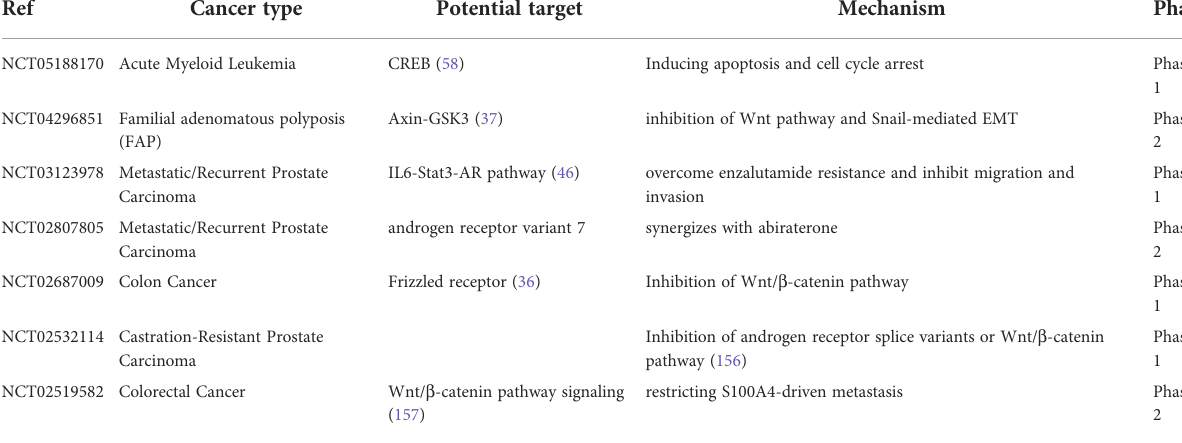
TABLE 3 The clinical trials using niclosamide for cancer